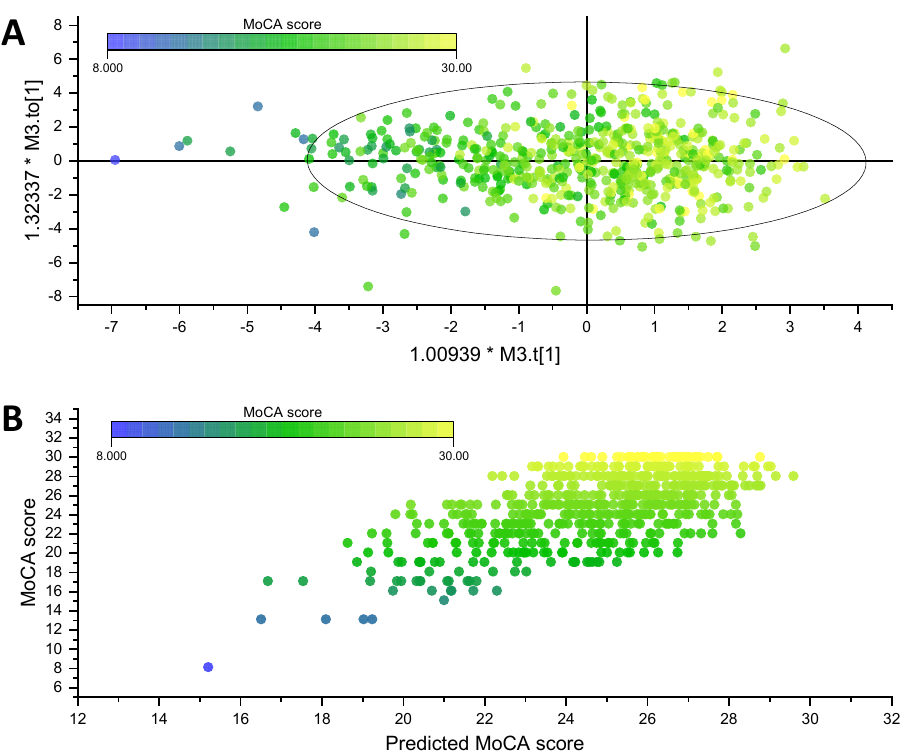
Figure 2. ( A ) Score plot of orthogonal projections to latent structures (OPLS) model constructed by gender, ethnicity, age, education and 23 phospholipid molecular species. ( B ) Regression of determined and predicted MoCA score by OPLS model.